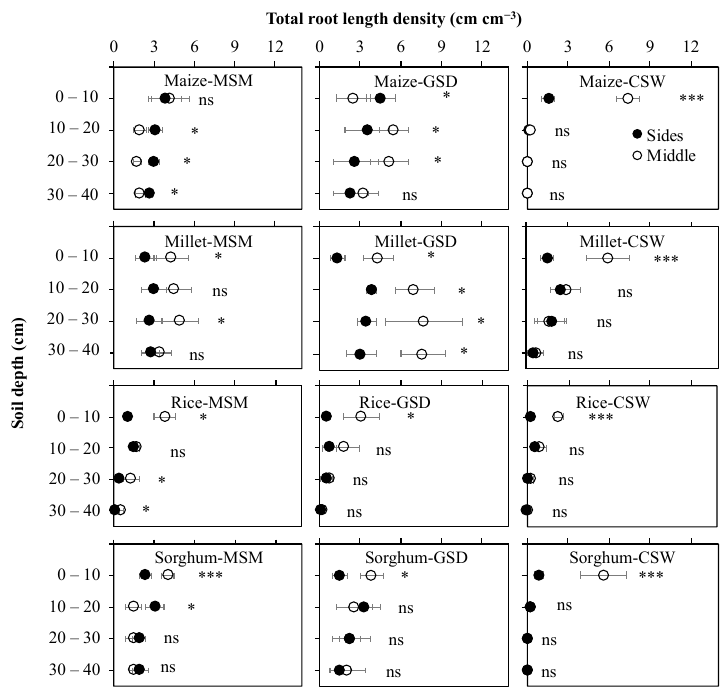
Figure 4. Effect of moderate soil moisture (MSM), gradual soil drying (GSD) and continuous soil waterlogging (CSW) on total root length density distribution in different soil columns in maize, millet, rice, and sorghum. Middle ( ○ ) denotes the value of total root length density distribution in the middle of the soil column, and Sides ( ● ) signifies the average value of total root length density distribution in the left side and right side of the soil columns. *, ***, and ns indicate statistical significance at p < 0.05, p < 0.001, and nonsignificance, respectively. Bar values indicate means ± standard deviation.